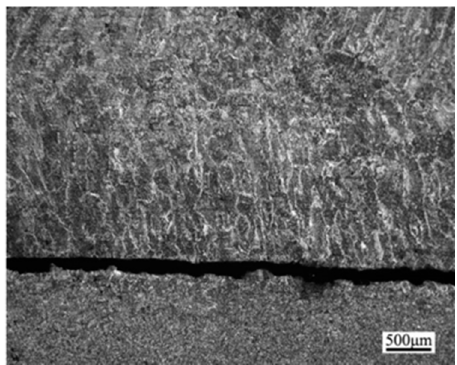
Figure 8. Crack morphology of longitudinal weld after pressure pulse test.